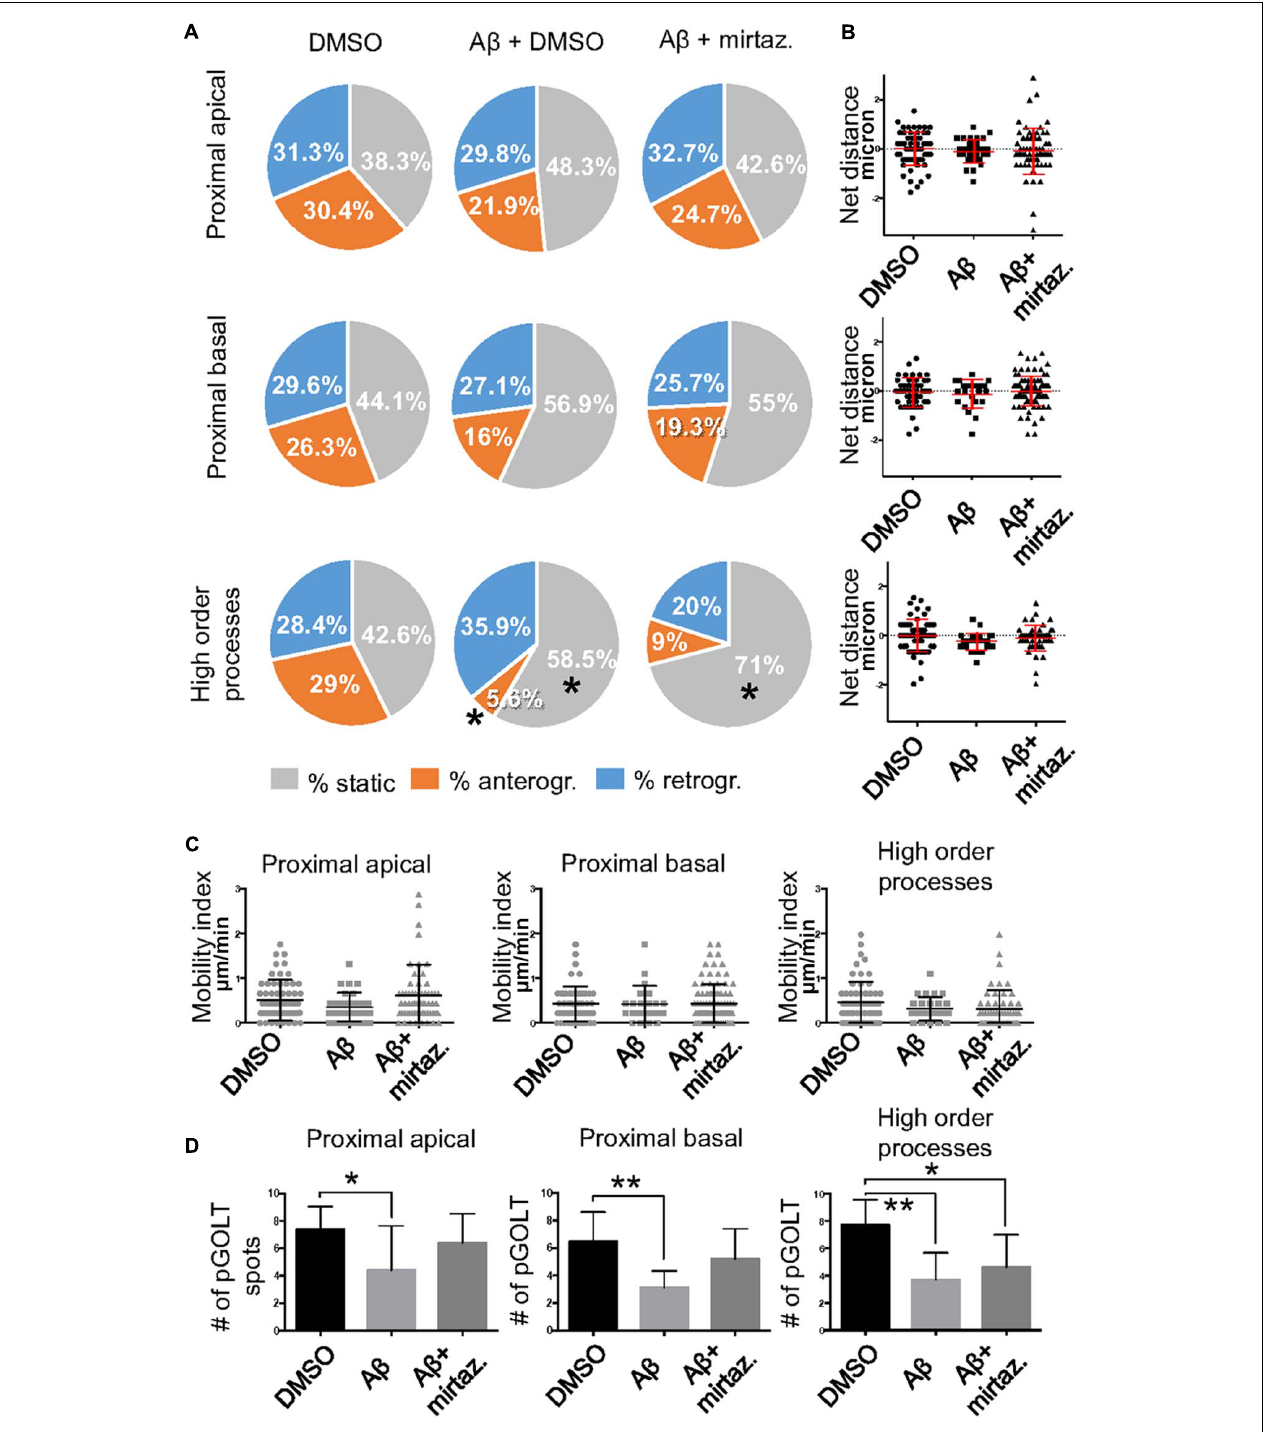
FIGURE 4 | Effects of A β and mirtazapine on pGOLT vesicle trafficking in unstimulated cultures. (A) Pie charts representation of the average percentage of anterograde, retrograde, and static pGOLT spots for each cell in cultures treated with A β and mirtazapine (both 10 µ M, 4 h). Data were obtained from 4 to 5 ROI segments in proximal apical, proximal basal, and higher order processes. DMSO: n = 8; A β + DMSO: n = 7; A β + mirtazapine: n = 10. (B) Scatter plot representation of net distance covered by pGOLT spots in the basal condition in proximal apical, proximal basal, and higher order processes after 4-h treatments. (C) Mobility index represents the velocity of pGOLT spots in the different segments analyzed, expressed in µ m/min, after 4 h of treatments. (D) Average of the number of pGOLT spots in the different segments. DMSO: n = 8; A β + DMSO: n = 7; A β + mirtazapine: n = 10. Following D’Agostino-Pearson’s normality test, we performed an unpaired t -test. * p ≤ 0.05; ** p ≤